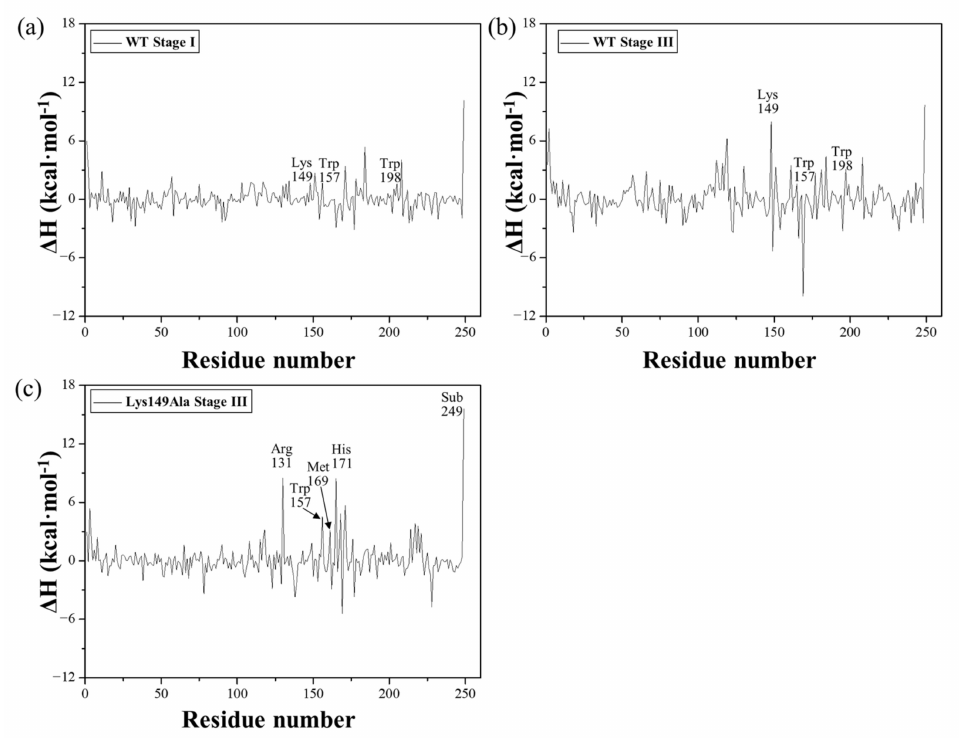
Figure 9. MM-PBSA energy decompositions of the barriers into residues for different stages revealed by the TMD simulations: ( a ) wild-type GsChdC, stage I; ( b ) wild-type of GsChdC, stage III and ( c ) Lys149Ala GsChdC, stage